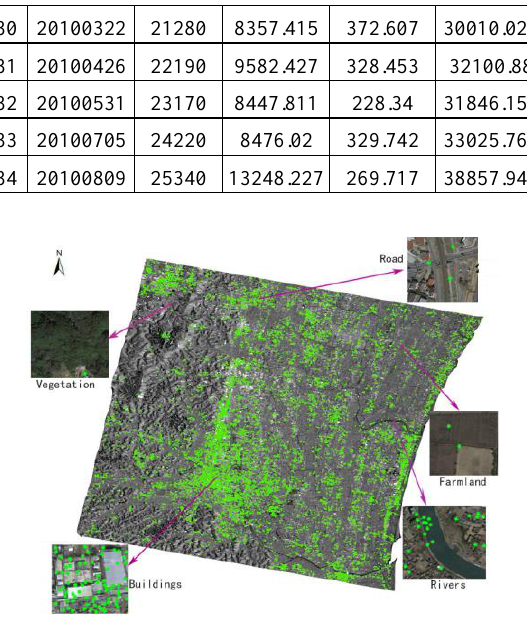
Figure 3 The distribution of Envisat ASAR’s PS